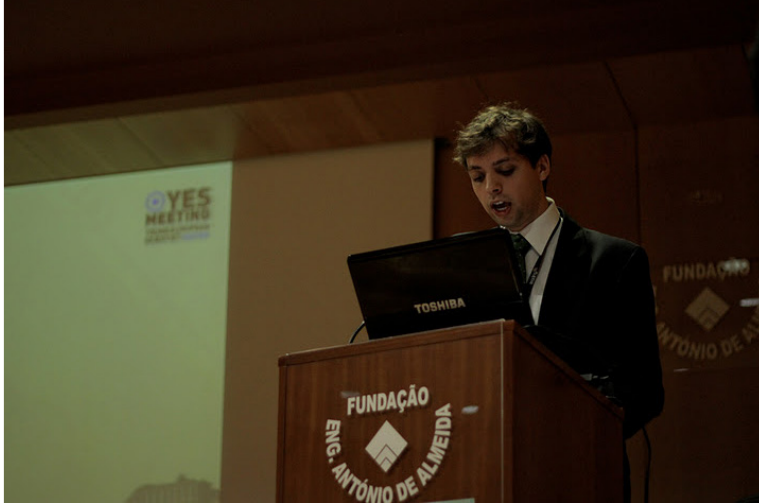
See photos of the YES Meeting on the next